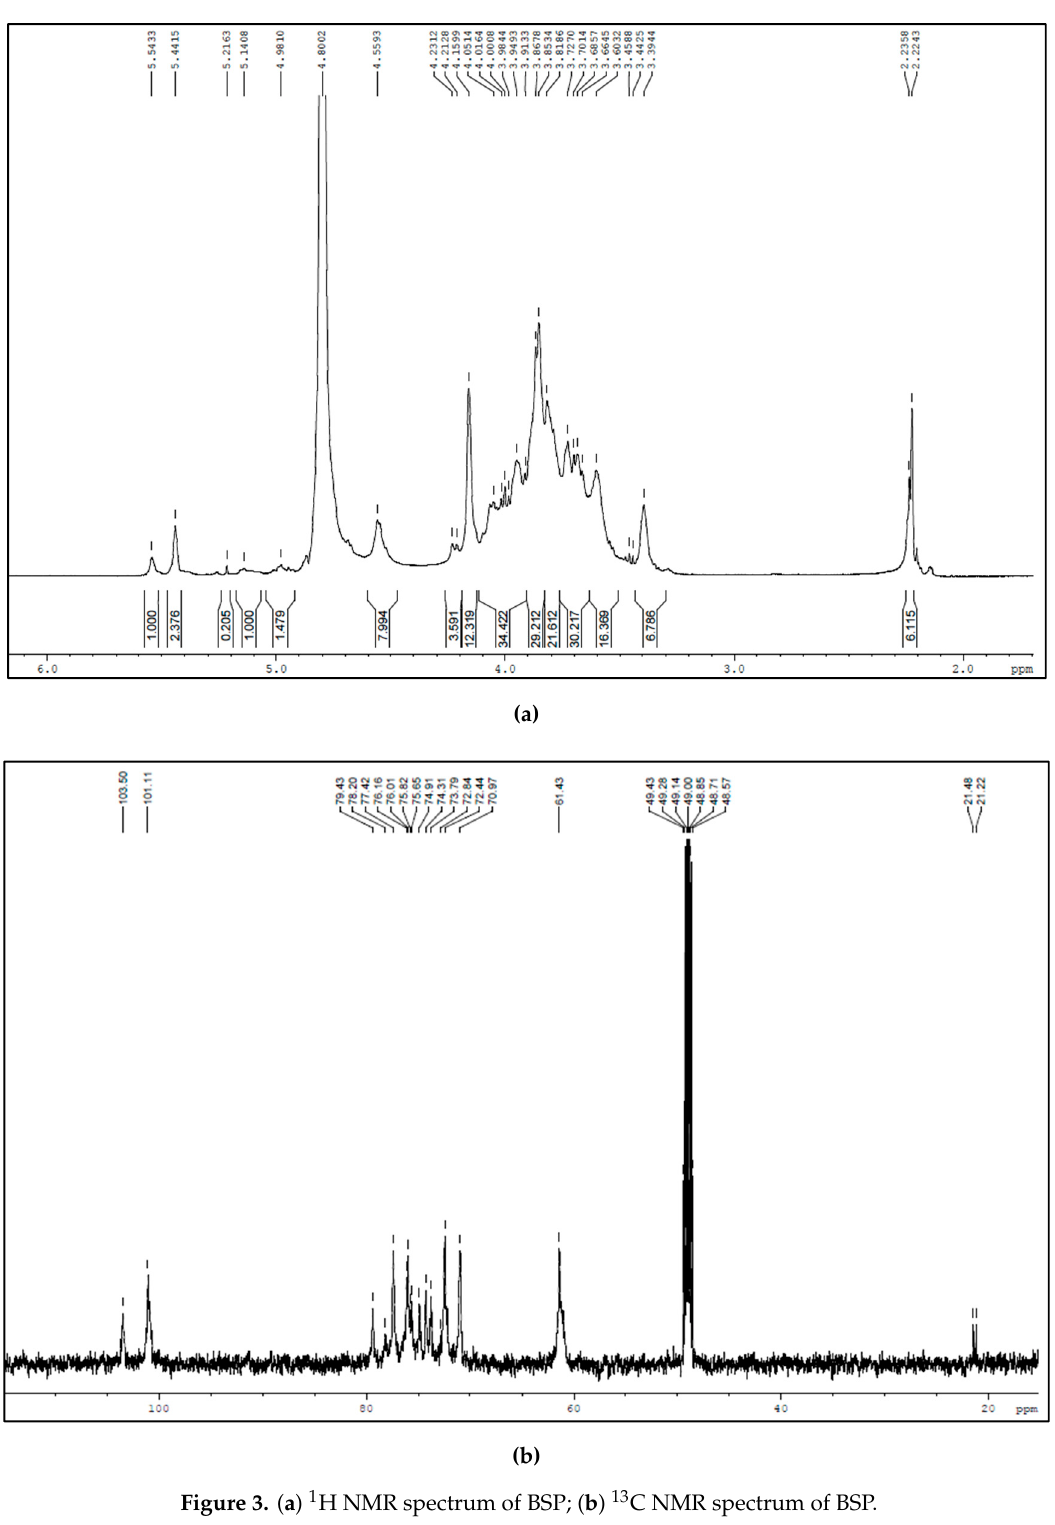
Figure 3. ( a ) 1 H NMR spectrum of BSP; ( b ) 13 C NMR spectrum of